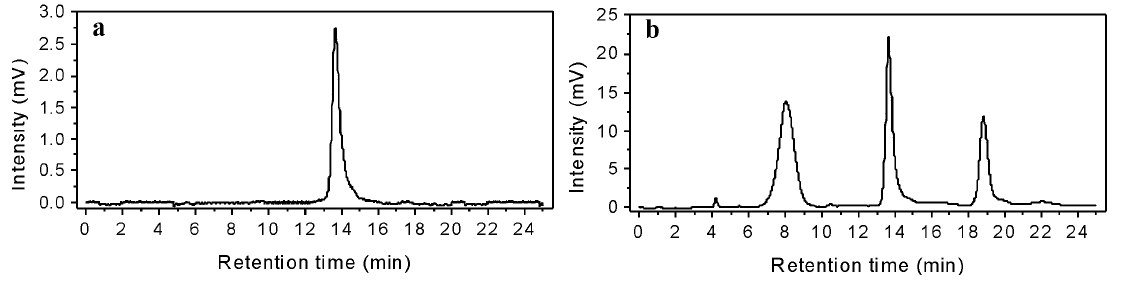
Figure 3. HPLC analysis of astaxanthin. Extracts from Coelastrum sp. HA-1 ( b ) had a peak at the same retention time as the astaxanthin standard ( a ).